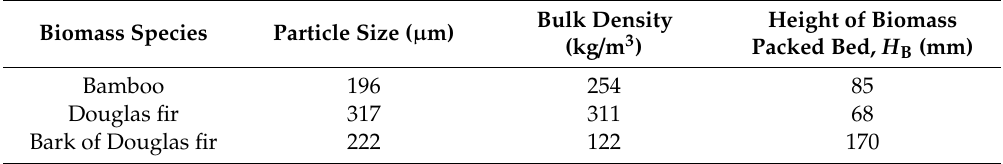
Figure 3. Experimental apparatus for measuring heat and mass transfer during the torrefaction of biomass. Table 3. Experimental conditions of the biomass packed bed.